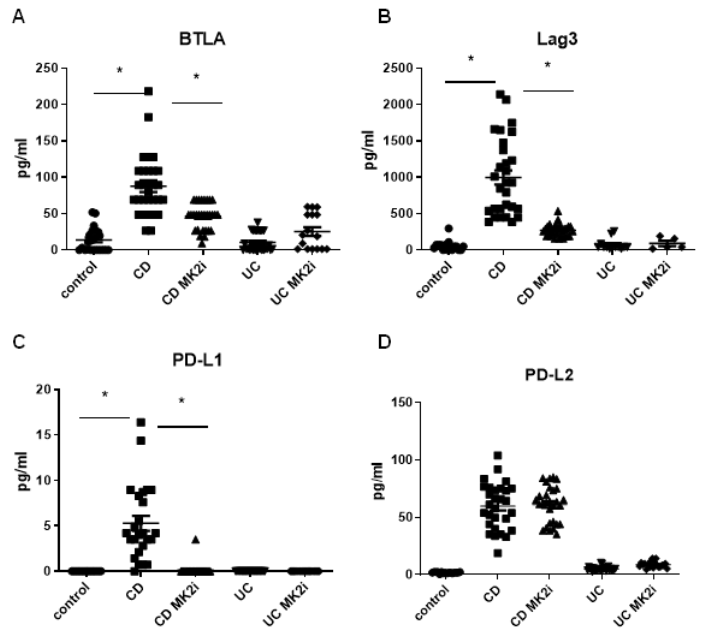
Figure 2 . Checkpoint molecules are cleaved from CD tissues in an MK2-dependent manner where supernatants from 4 mg tissues pieces were incubated with MK2i or vehicle control and supernatants run on checkpoint multiplex array indicating that ( A ) BTLA, ( B ) Lag3, ( C ) PD-L1, and ( D ) PD-L2 were measured and shown to be cleaved into supernatants, which was reversed by MK2i treatment, but not with UC tissues. N = 23 for control, 29 for CD, and 27 for UC, * p < 0.05.